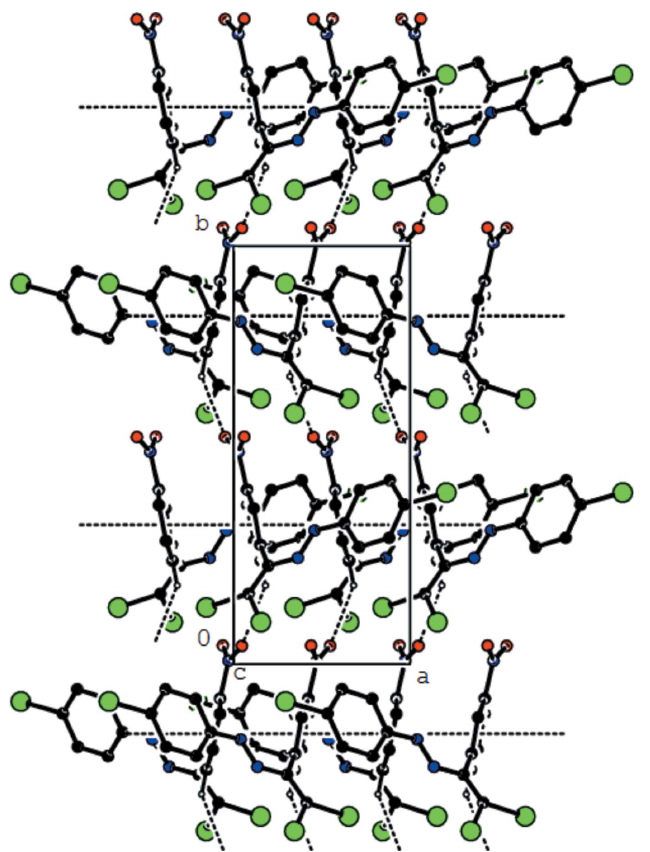
Figure 4 View down the c -axis of the C—H (cid:2)(cid:2)(cid:2) O and (cid:2) – (cid:2) interactions (dashed lines) in the title compound. form-1 of the title compound (Akkurt et al. , 2022), C—H (cid:2) (cid:2) (cid:2) Br interactions connect molecules, generating zigzag C (8) chains along the [100] direction, which are linked by C—Br (cid:2) (cid:2) (cid:2) (cid:2) interactions into layers parallel to (001), and van der Waals interactions between layers contribute to the crystal cohesion. Crystal Explorer 17.5 (Turner et al. , 2017) was used to perform a Hirshfeld surface analysis of form-2 and to generate the related two-dimensional fingerprint plots, with a standard resolution of the three-dimensional d surfaces plotted over norm a fixed colour scale of (cid:4) 0.1471 (red) to +1.1715 (blue) a.u.